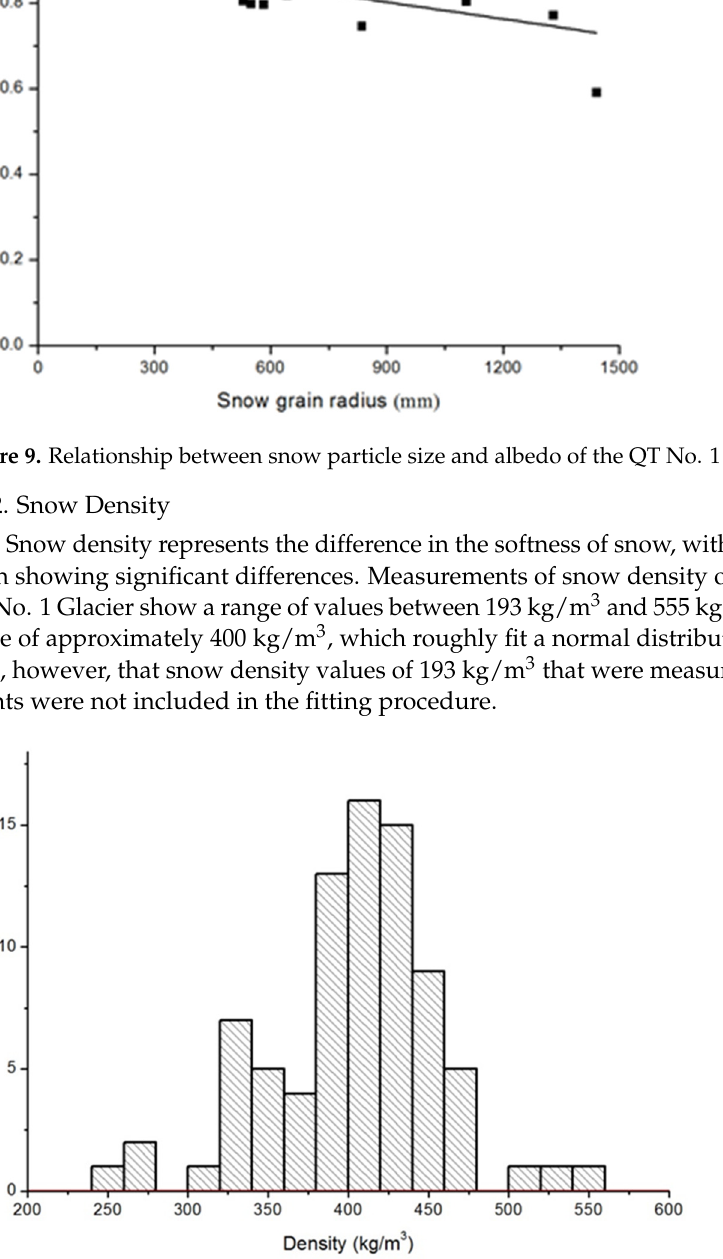
Figure 10. Ranges of snow density distributions in 2013 and 2015.